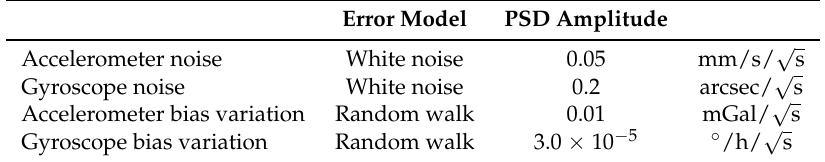
Table 4. Stochastic models and amplitude of the associated Power Spectral Densities